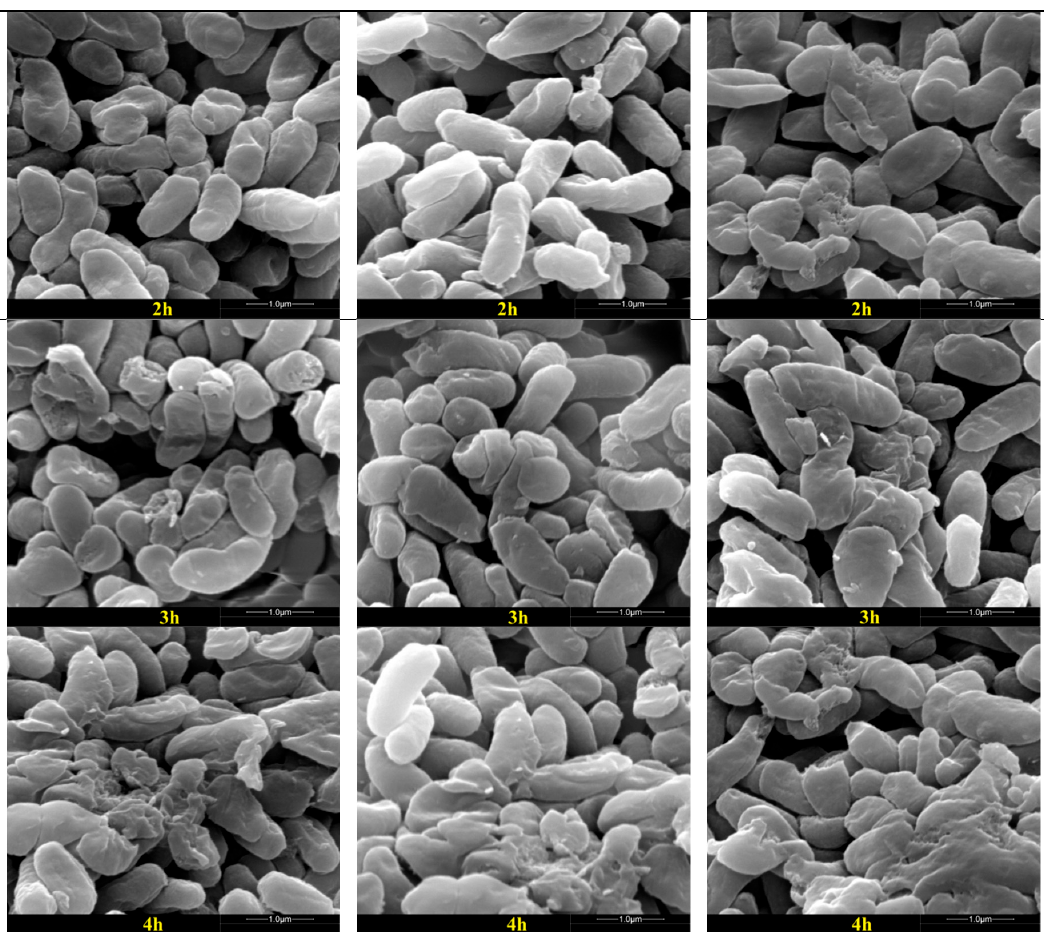
Figure 2. Effects of L, C, and C-L on E. coli CVCC 245 morphology and integrity. The first, second, and third columns were bacteria treated with 1× minimal inhibitory concentrations (MICs) L, C, and C-L, respectively. The lines from top to bottom were bacteria untreated (C group) and treated on 1, 2, 3, and 4 h.